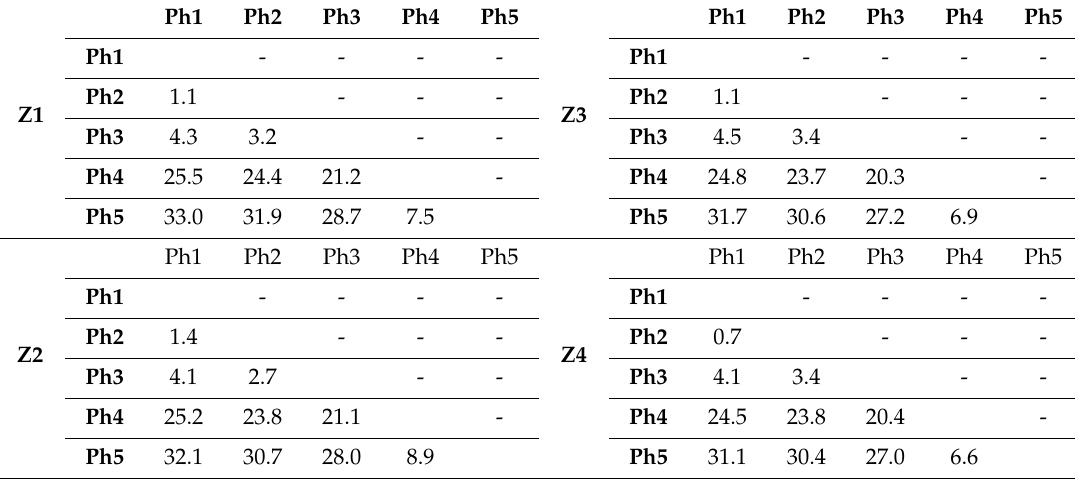
Table 4. Duration of the vegetative phases (Ph1-Ph5) in 2017, for trees in individual zones (Z) (in